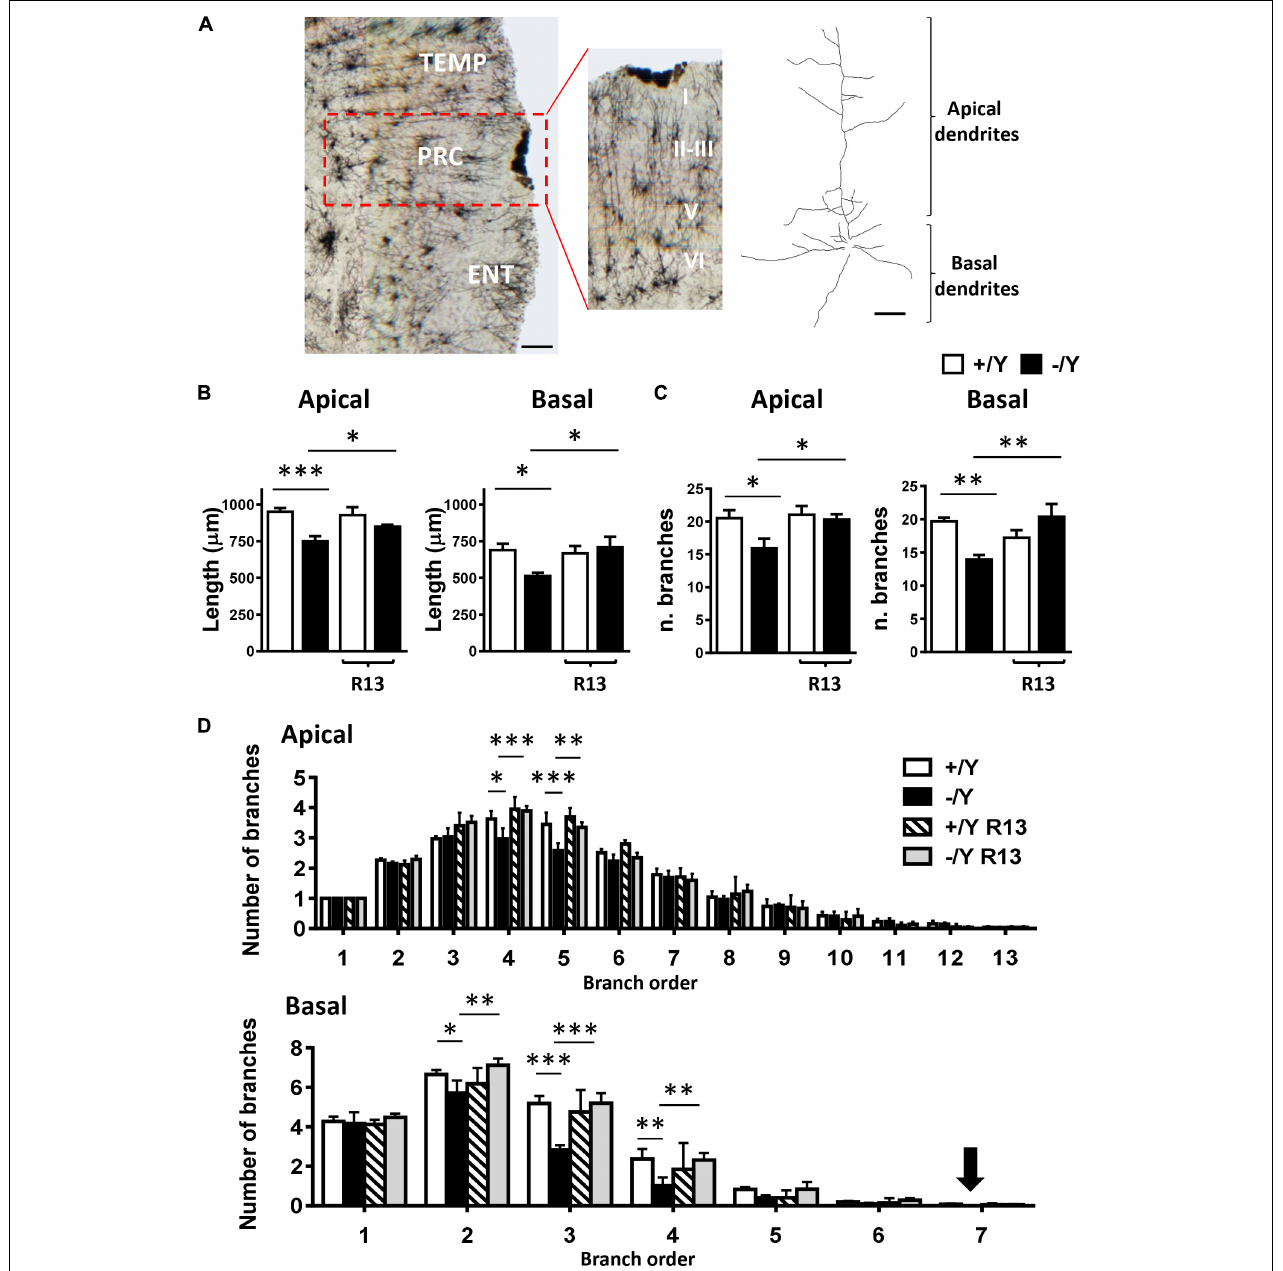
FIGURE 6 | Effect of treatment with R13 on dendritic morphology in the perirhinal cortex of Cdkl5 − /Y mice. (A) Example of Golgi-stained section at the level of the PRC of a P50 Cdkl5 − /Y mouse (panel on the left; scale bar = 100 µ m). The central panel shows a higher magnification of the area enclosed in the red square. Roman numerals indicate PRC cytoarchitectonic layers. The panel on the right shows an example of the apical and basal dendritic tree of a Golgi-stained PRC neuron from layers II-III (scale bar = 30 µ m). (B) Apical and basal mean total dendritic length of layer II-III PRC neurons of vehicle-treated P50 Cdkl5 +/Y ( n = 4) and Cdkl5 − /Y ( n = 4) mice, and R13-treated P50 Cdkl5 +/Y ( n = 4) and Cdkl5 − /Y ( n = 5) mice. (C) Mean number of dendritic segments of the apical and basal dendrites of layer II-III PRC neurons in the same mice as in (B) . (D) Mean number of apical and basal branches of the different orders of vehicle-treated Cdkl5 +/Y ( n = 4) and Cdkl5 − /Y ( n = 4) mice, and R13-treated Cdkl5 − /Y ( n = 5) mice. The numbers on the X axis indicate the branch order. The arrow indicates the absence of branches in Cdkl5 − /Y mice. Values in (B–D) represent mean ± SE. ∗ p < 0.05; ∗∗ p < 0.01; ∗∗∗ p < 0.001 (Fisher’s LSD test after two-way ANOVA).